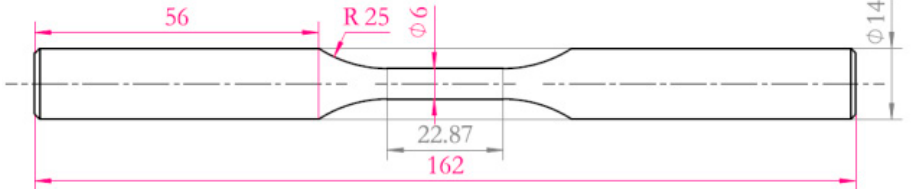
Figure 2. Shape and size of the specimens used for fatigue tests.